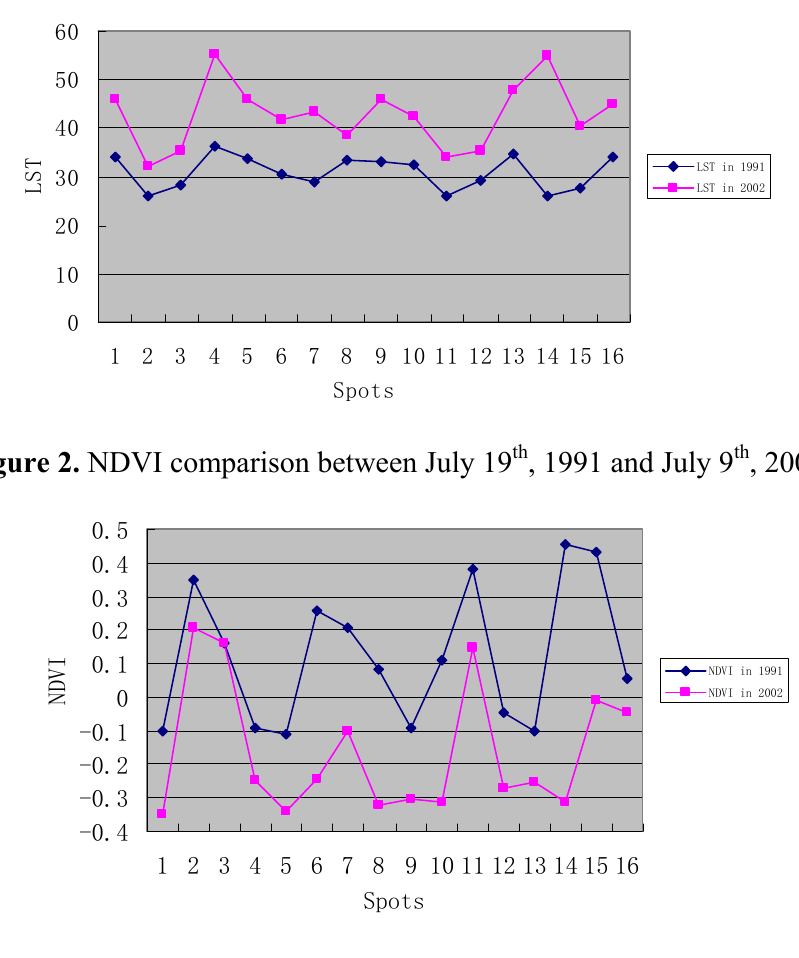
Figure 1. Land surface temperature (LST) comparison between July 19 th , 1991 and July 9 th , 2002.